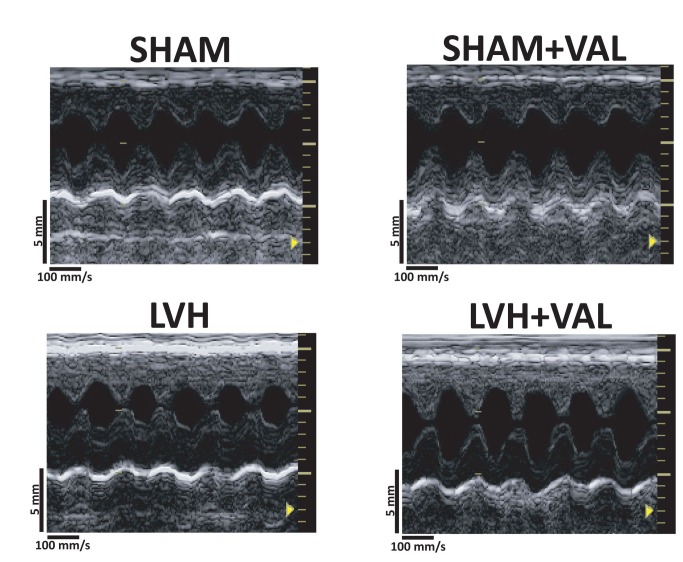
Representative echocardiographic acquisitions from each group of rats.Two-dimensional parasternal long axis images demonstrating increase in wall thickness after ascending aorta banding (LVH) compared to control groups (SHAM, top left panel; SHAM+VAL, top right panel) and reduction in the extent of hypertrophy after chronic valsartan administration (LVH+VAL). Depth: 5mm, digital acquisition speed: 100mm/s.